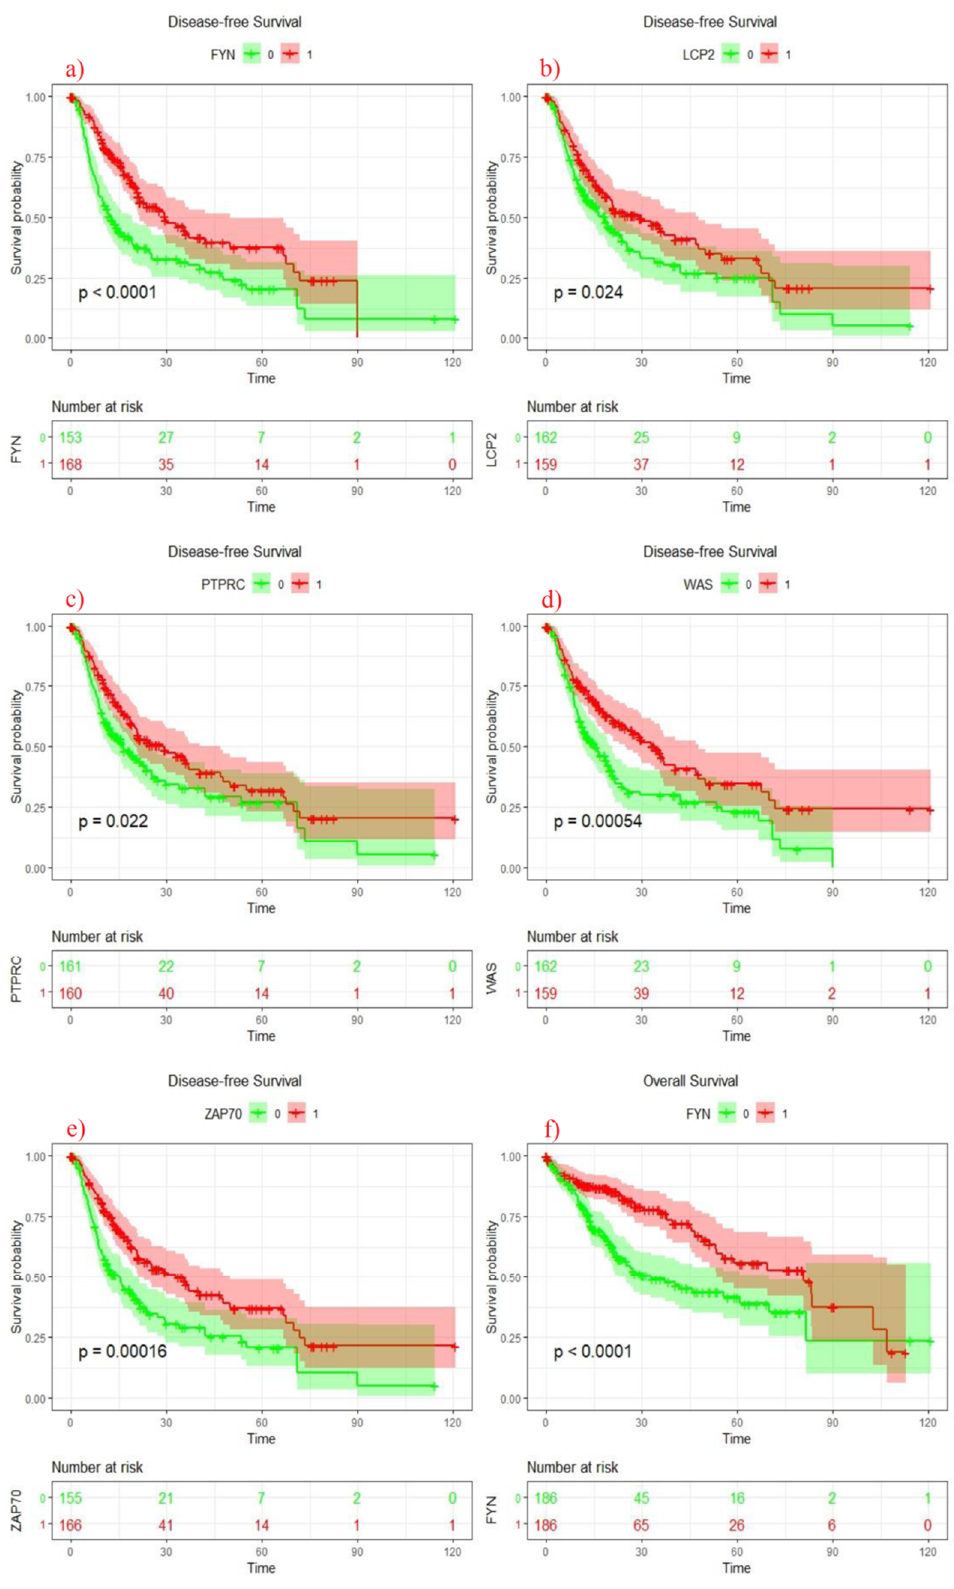
Figure 3. Kaplan–Meier estimates of disease-free survival of ( a ): FYN, ( b ): LCP2 ( c ): PTPRC, ( d ): WAS, ( e ): ZAP70 expression in HCC patients (Validation cohort) ( f ): Kaplan–Meier estimates of overall survival of FYN expression in HCC patients (Validation cohort).